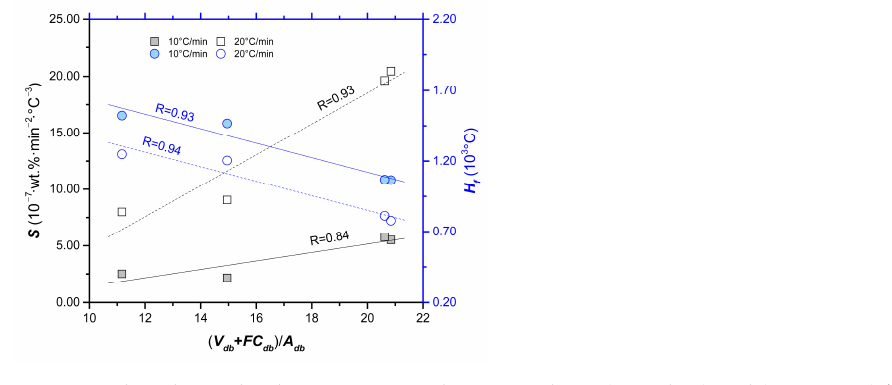
Figure 3. The relationship between comprehensive indexes ( S i and H f ) and ( V ad + FC ad )/ A ad .